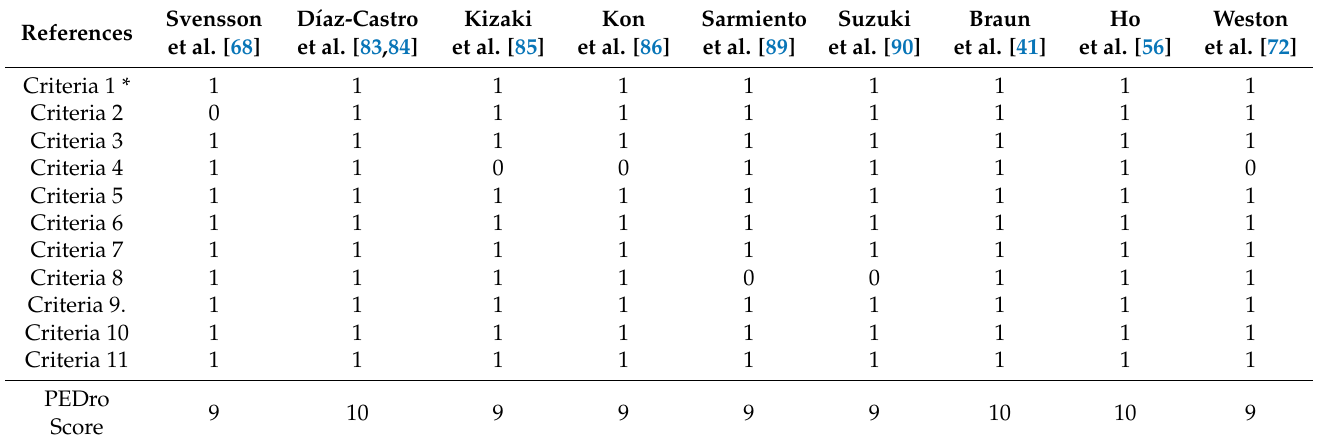
Table 1. Methodological quality of the studies included in the systematic review. Assessment of the methodological quality of studies using the PEDro